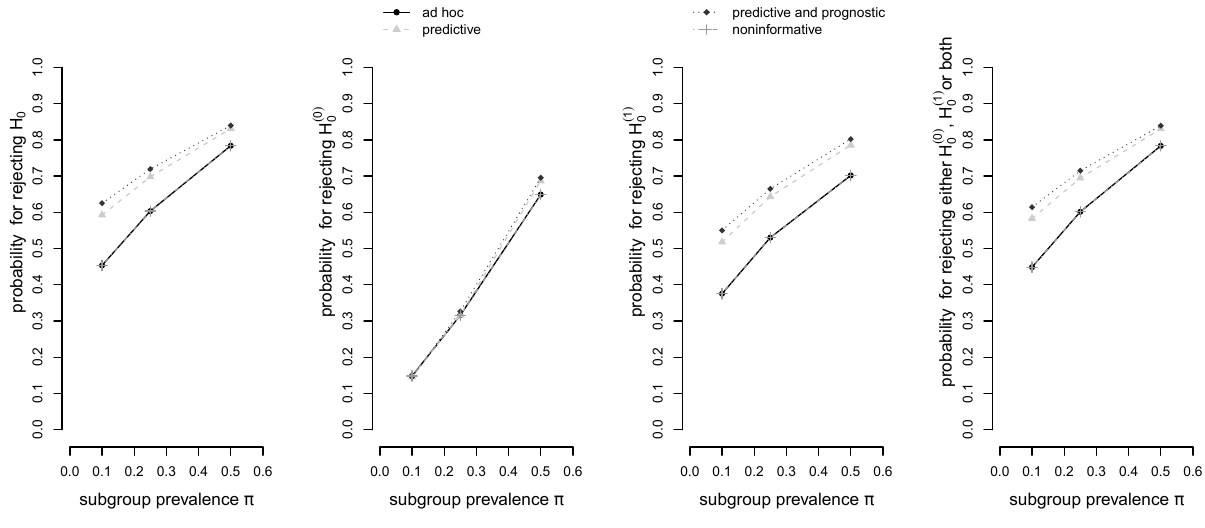
= 0 : 45 ; p = 0 : 3 ; T 1 C 1